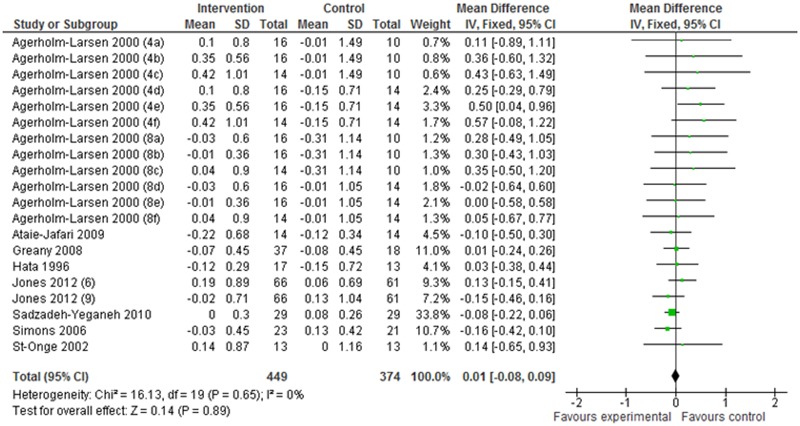
Effects of probiotics on changes in serum TG levels.Values in parentheses indicate intake duration (weeks). a, b, and c in parentheses indicate Gaio, Stra, and StLa vs PP, respectively; d, e, and f in parentheses indicate Gaio, Stra, and StLa vs PY, respectively. PP: placebo pill; PY: placebo yogurt; StLa: Streptococcus thermophilus and Lactobacillus acidophilus; StLr: Streptococcus thermophilus and Lactobacillus rhamnosus.